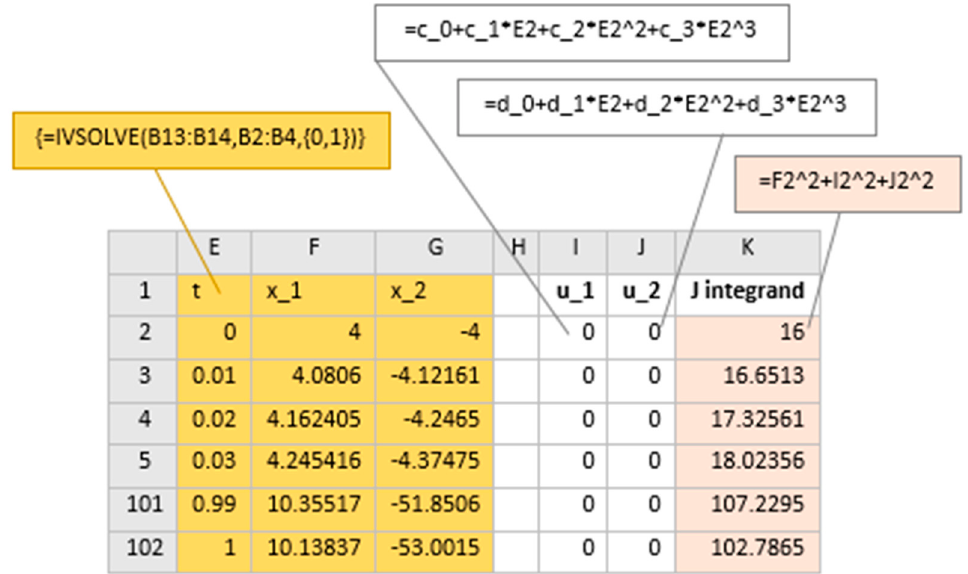
Figure 10 . Partial display of IVP (12)–(14) solution obtained by IVSOLVE formula (16), and dependent generated columns for the parametrized controls formulas, and the integrand expression for the cost index (11).